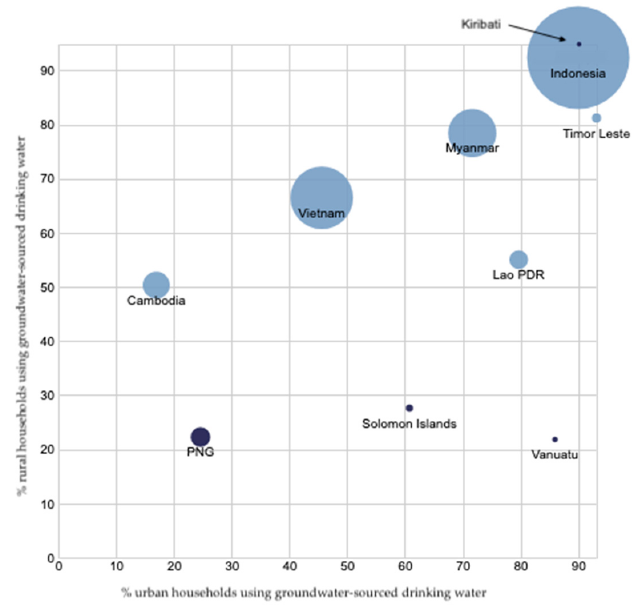
Figure 2. Proportion of urban and rural households using groundwater as their primary source of drinking water with associated relative populations across countries indicated by circle